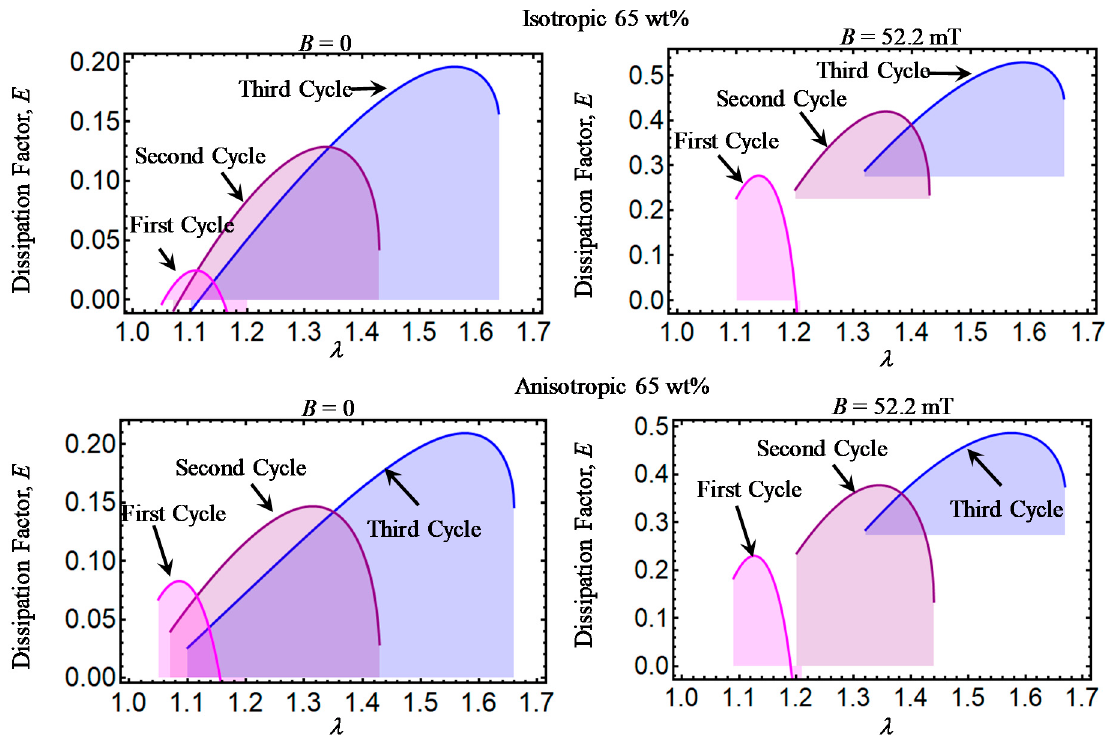
Figure 9. Dissipation factor curves for magnetorheological material samples made with a concentration of 65 wt% of CIPs.